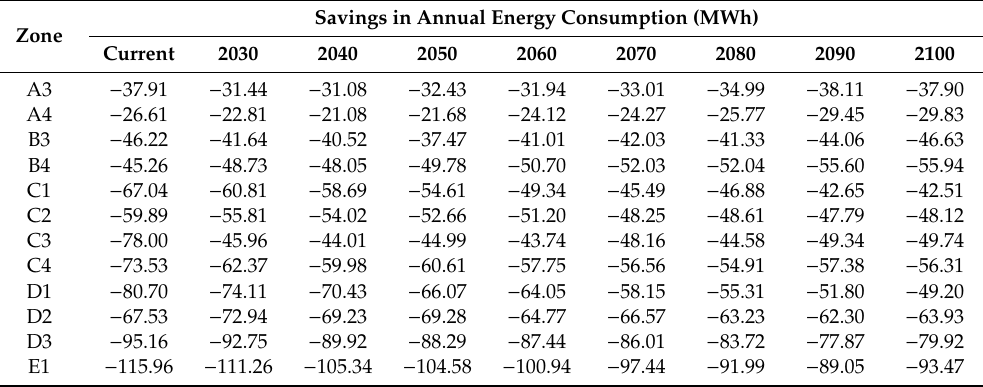
Table 6. Energy saving obtained with ETICSS considering an operational pattern based on teleworking.